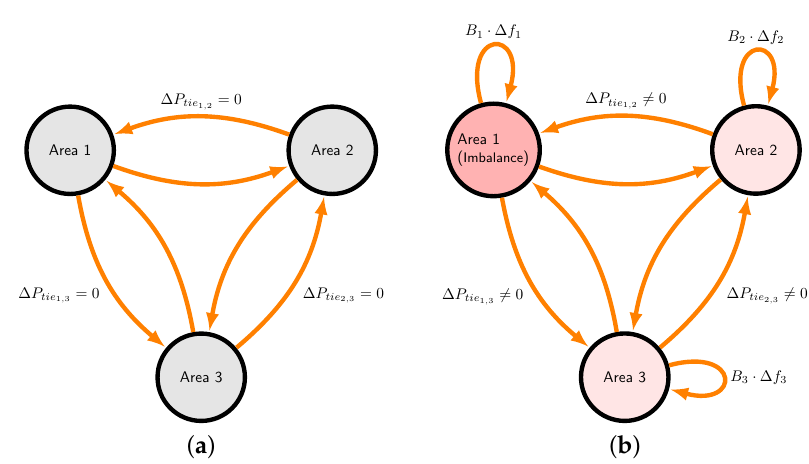
Figure 3. Multi-area power system. ( a ) balanced situation; ( b ) imbalanced situation in Area 1.